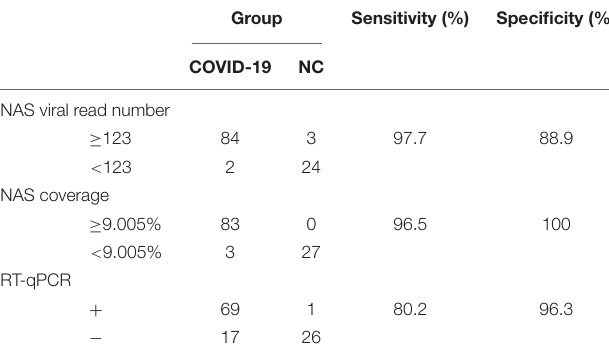
Frontiers in Microbiology |